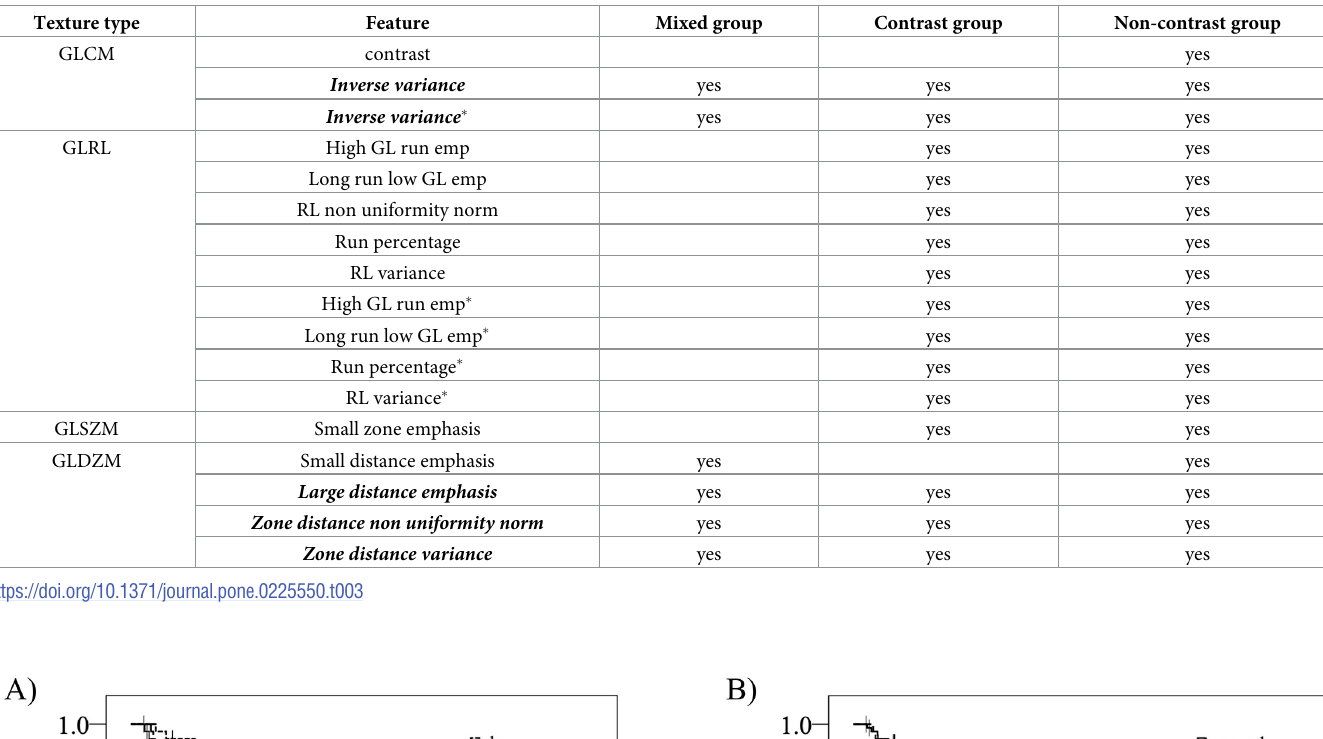
Table 3. List of stable radiomic features not statistically different if extracted using one segment layer at a time or considering the whole tumour volume in CT images of the oesophagus. In bold, common features among three cohorts considered that showed to be stable and dimensionality and contrast agent independent. GLCM, grey level co-occurrence matrix; GLRLM, grey level run length matrix; GLSZM, grey level size zone matrix; GLDZM, grey level distance zone matrix; NGTDM, neighbourhood grey tone difference matrix; � , feature computed with merging.